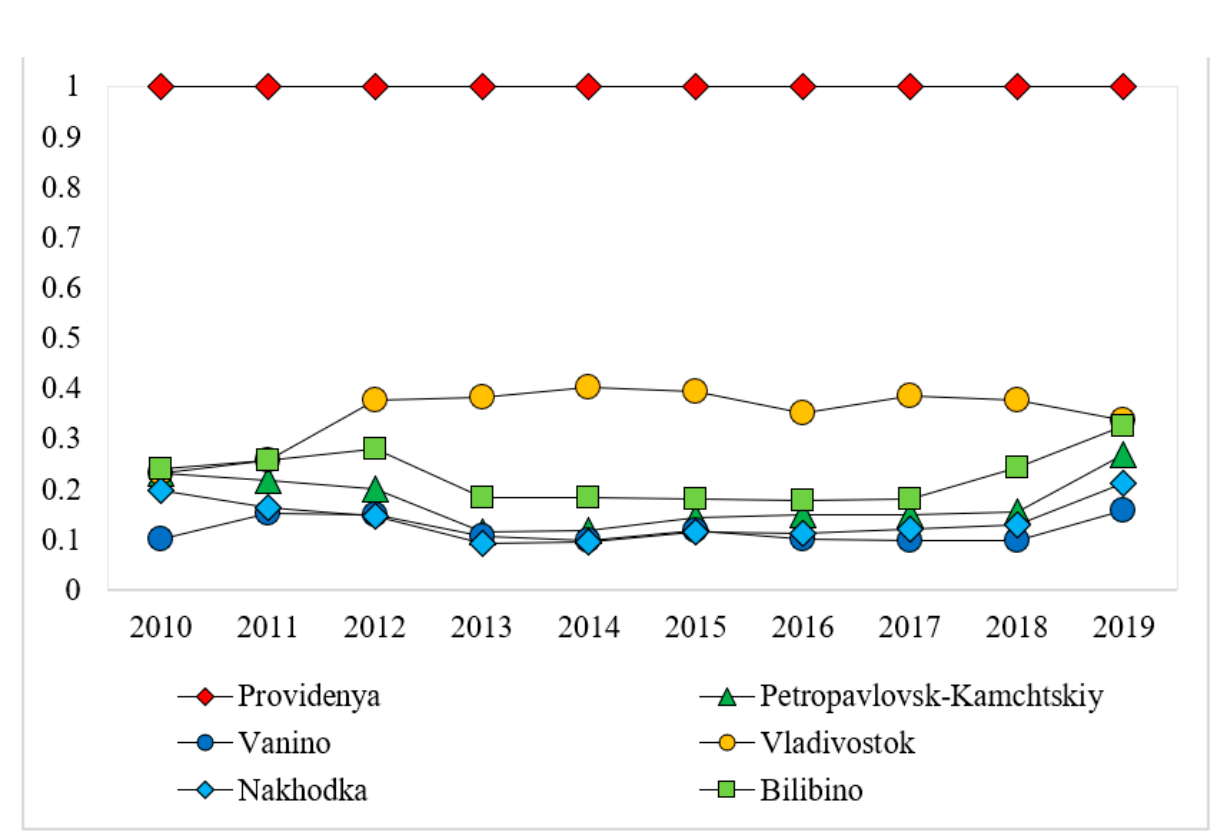
Figure 4. Variations in eco ‐ efficiency scores of cities along the eastern section of the NSR across the years 2010–2019.